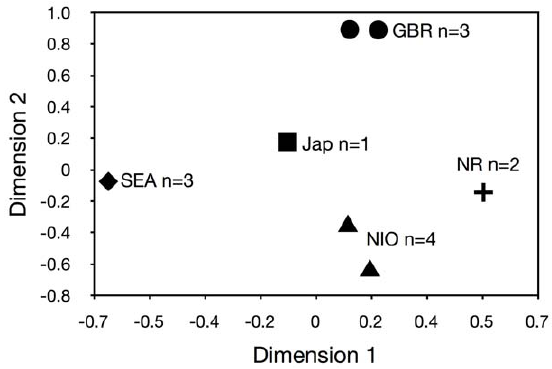
Figure 4. Multidimensional Scaling (MDS) of Neotrygonkuhlii. Ningaloo Reef (NR), northern Indian Ocean (NIO), Great Barrier Reef (GBR), Japan (Jap), Southeast Asia (SEA);.